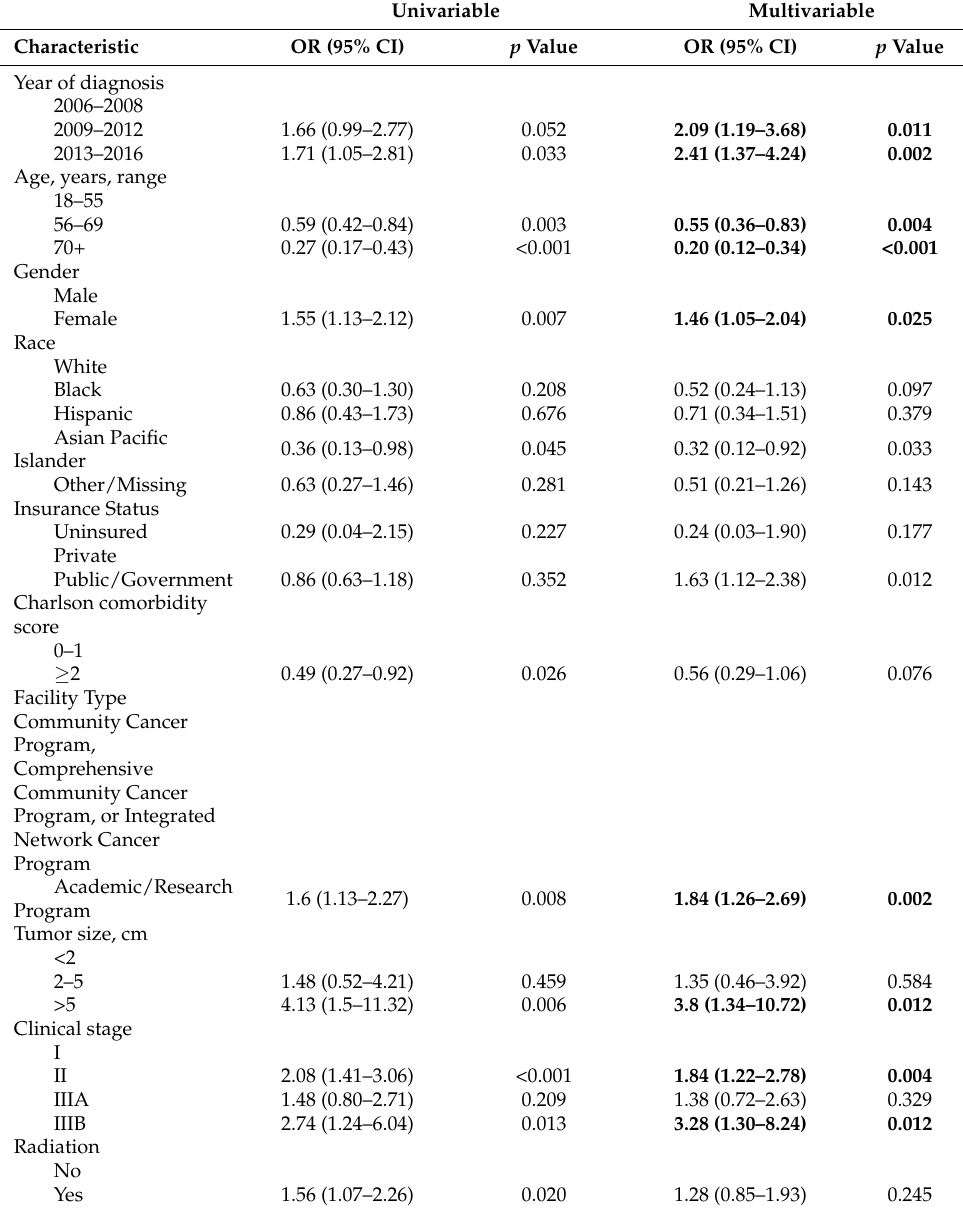
Table 2. Univariable and multivariable logistic regression analyses for factors associated with use of neoadjuvant therapy.